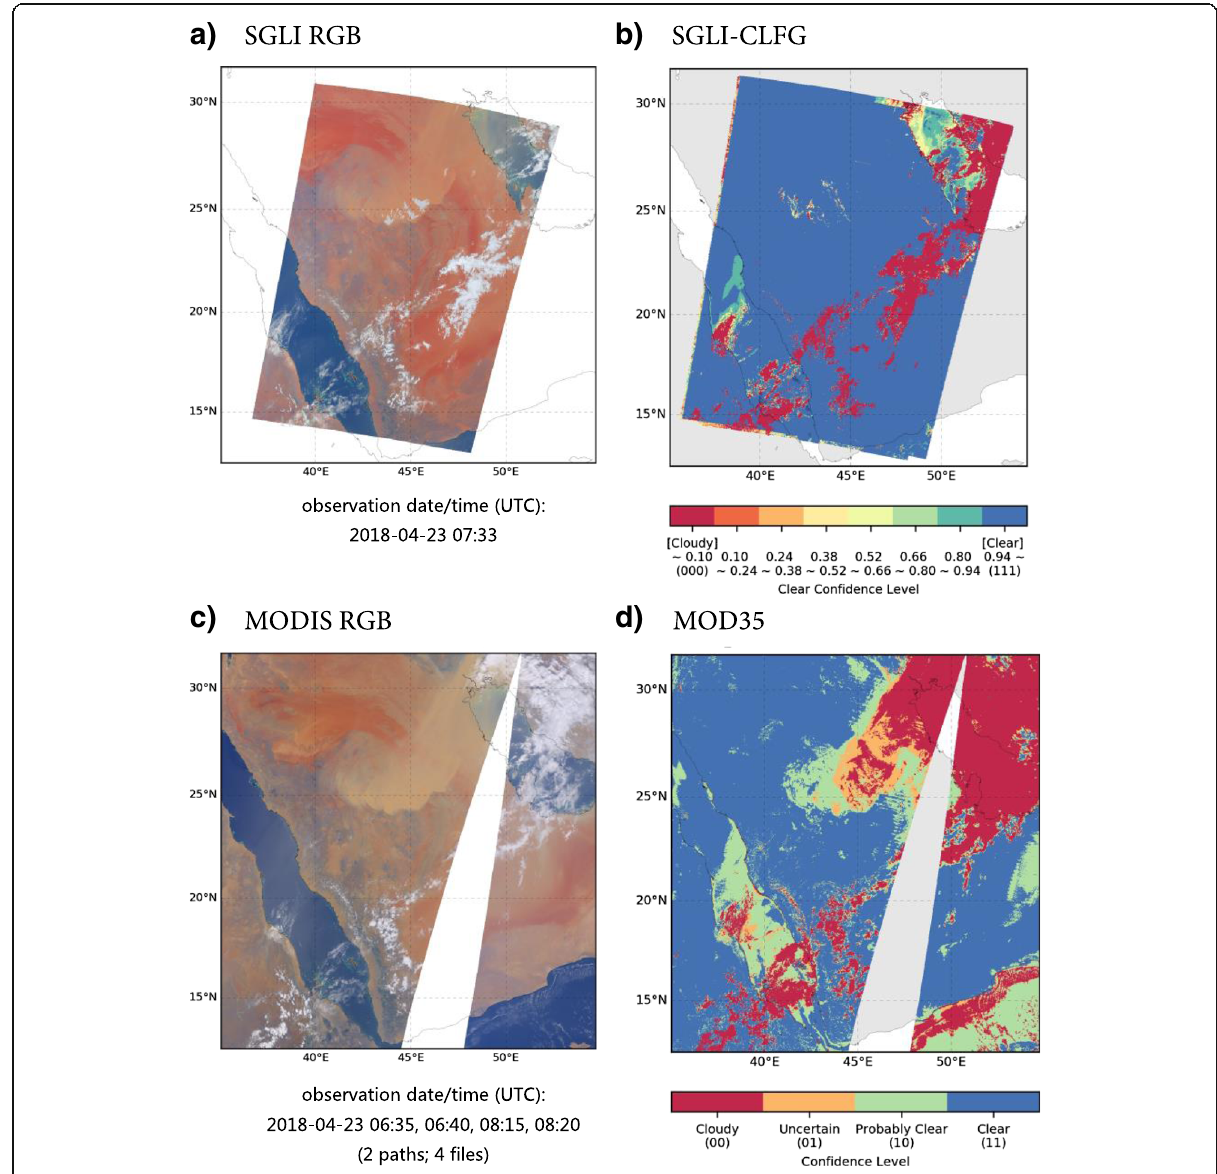
Fig. 15. Same as Fig. 12, but over the Arabian Peninsula on April 23,